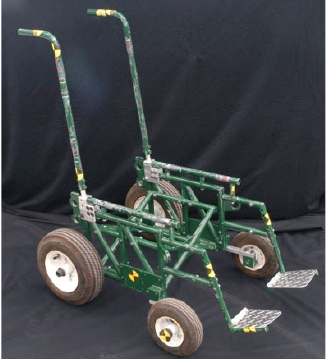
Figure 12. Surrogate wheelchair frame.